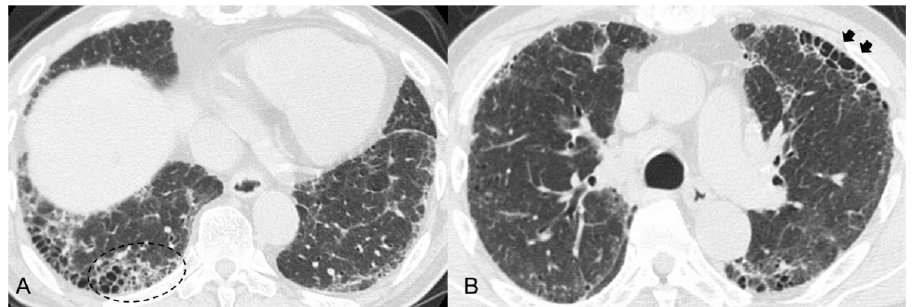
Figure 1. ( A ) High-resolution computed tomography (HRCT) scan shows increased attenuation around honeycombing and traction bronchiectasis (dashed circle). ( B ) HRCT shows anterior upper lobe honeycomb-like lesion as a concentration of cystic air spaces within the anterior aspect of the upper lobes (black arrows). Table 1. Characteristics and HRCT/pathological findings in MPO-ANCA-positive ILD and